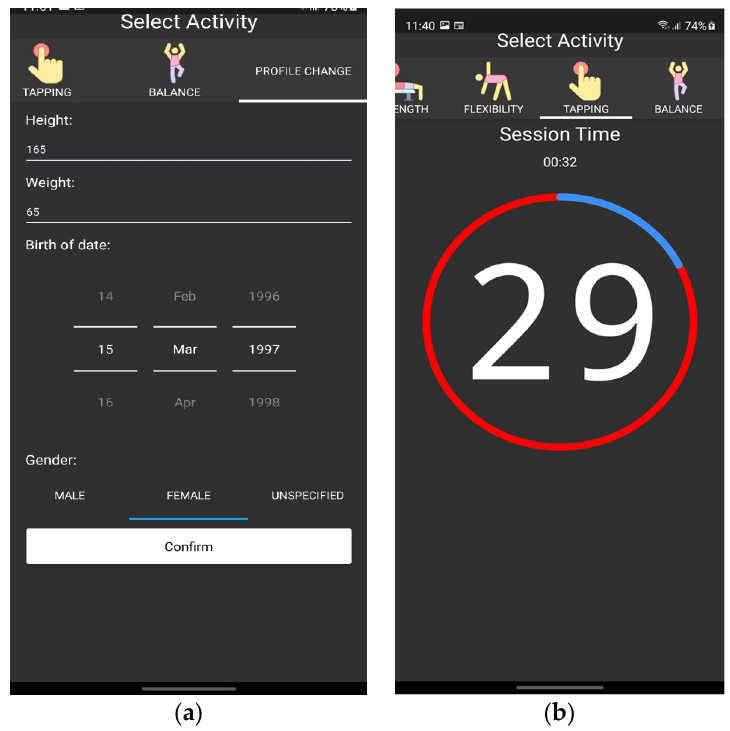
Figure 8. Mobile app: ( a ) registration form; ( b ) an example of evaluation process.